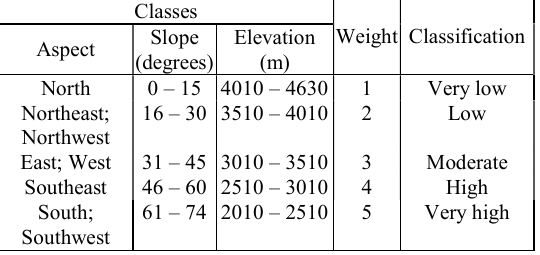
Table 3. Weighting according to the topographic data